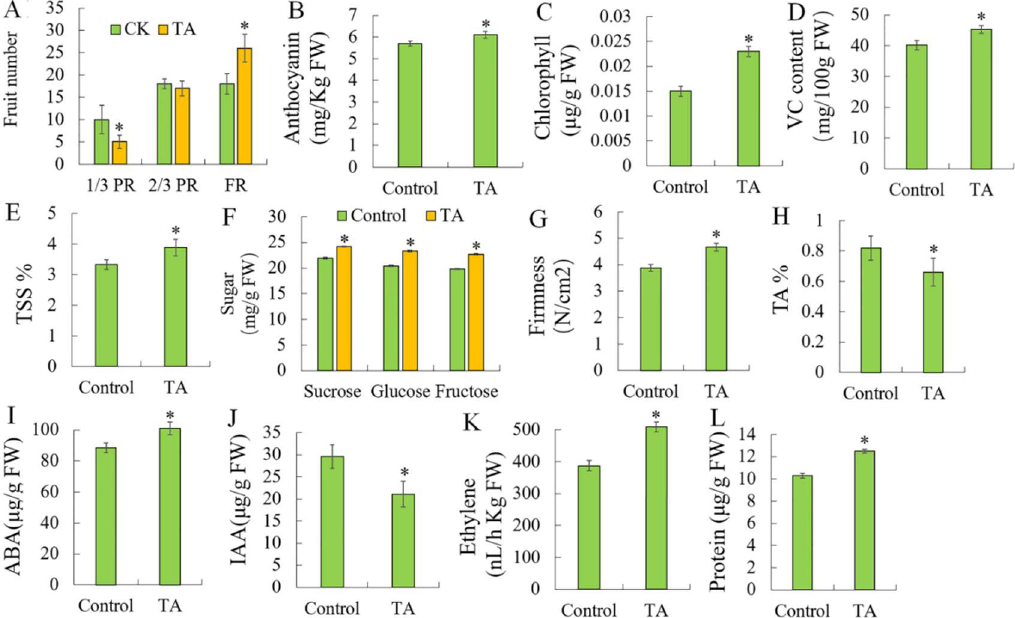
Figure 1. E ff ects of triacontanol on strawberry fruit ripening. ( A ). Fruit number. ( B ). Anthocyanin Figure 1. Effects of triacontanol on strawberry fruit ripening. A . Fruit number. B . Anthocyanin content. content. ( C ). Chlorophyll content. ( D ). VC (vitamin C) content. ( E ). TSS % (total soluble C . Chlorophyll content. D . VC ( vitamin C ) content. E . TSS % (total soluble solid). F . Sugar content. G .